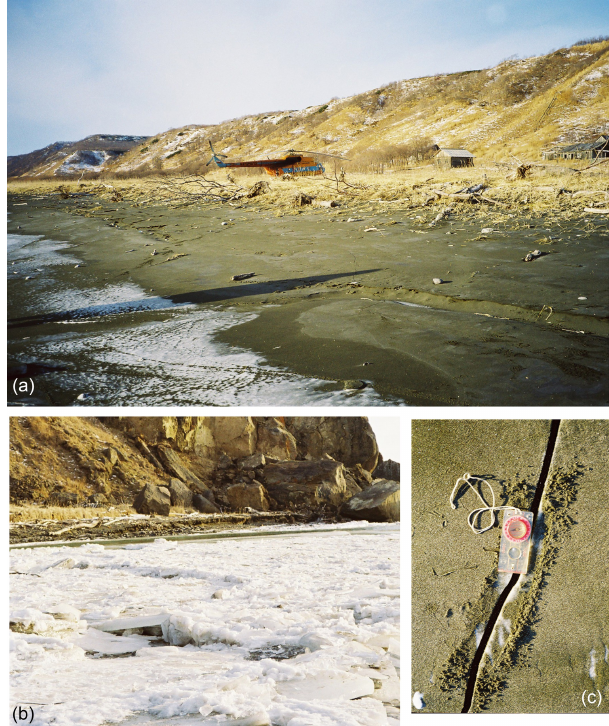
Figure 3. Photos taken by T. Pinegina on 9 December 1997 near Kronotsky Cape (location in Fig. 1). For an additional photo and sketch for context, see Fig. S3. (a) With helicopter for scale: the tsunami deposited sand on the snow up to about the line of grassy vegetation at the back of the beach (see detail, lower right photo); white zone in foreground is sea foam. (b) Ice and snow broken up by the tsunami (excerpted from photo in Fig. S3). (c) With compass for scale: detail of tsunami-deposited sand above snow that covered the beach, scraped by hand away from a crack in the snow/ice which is interpreted to have been made during an